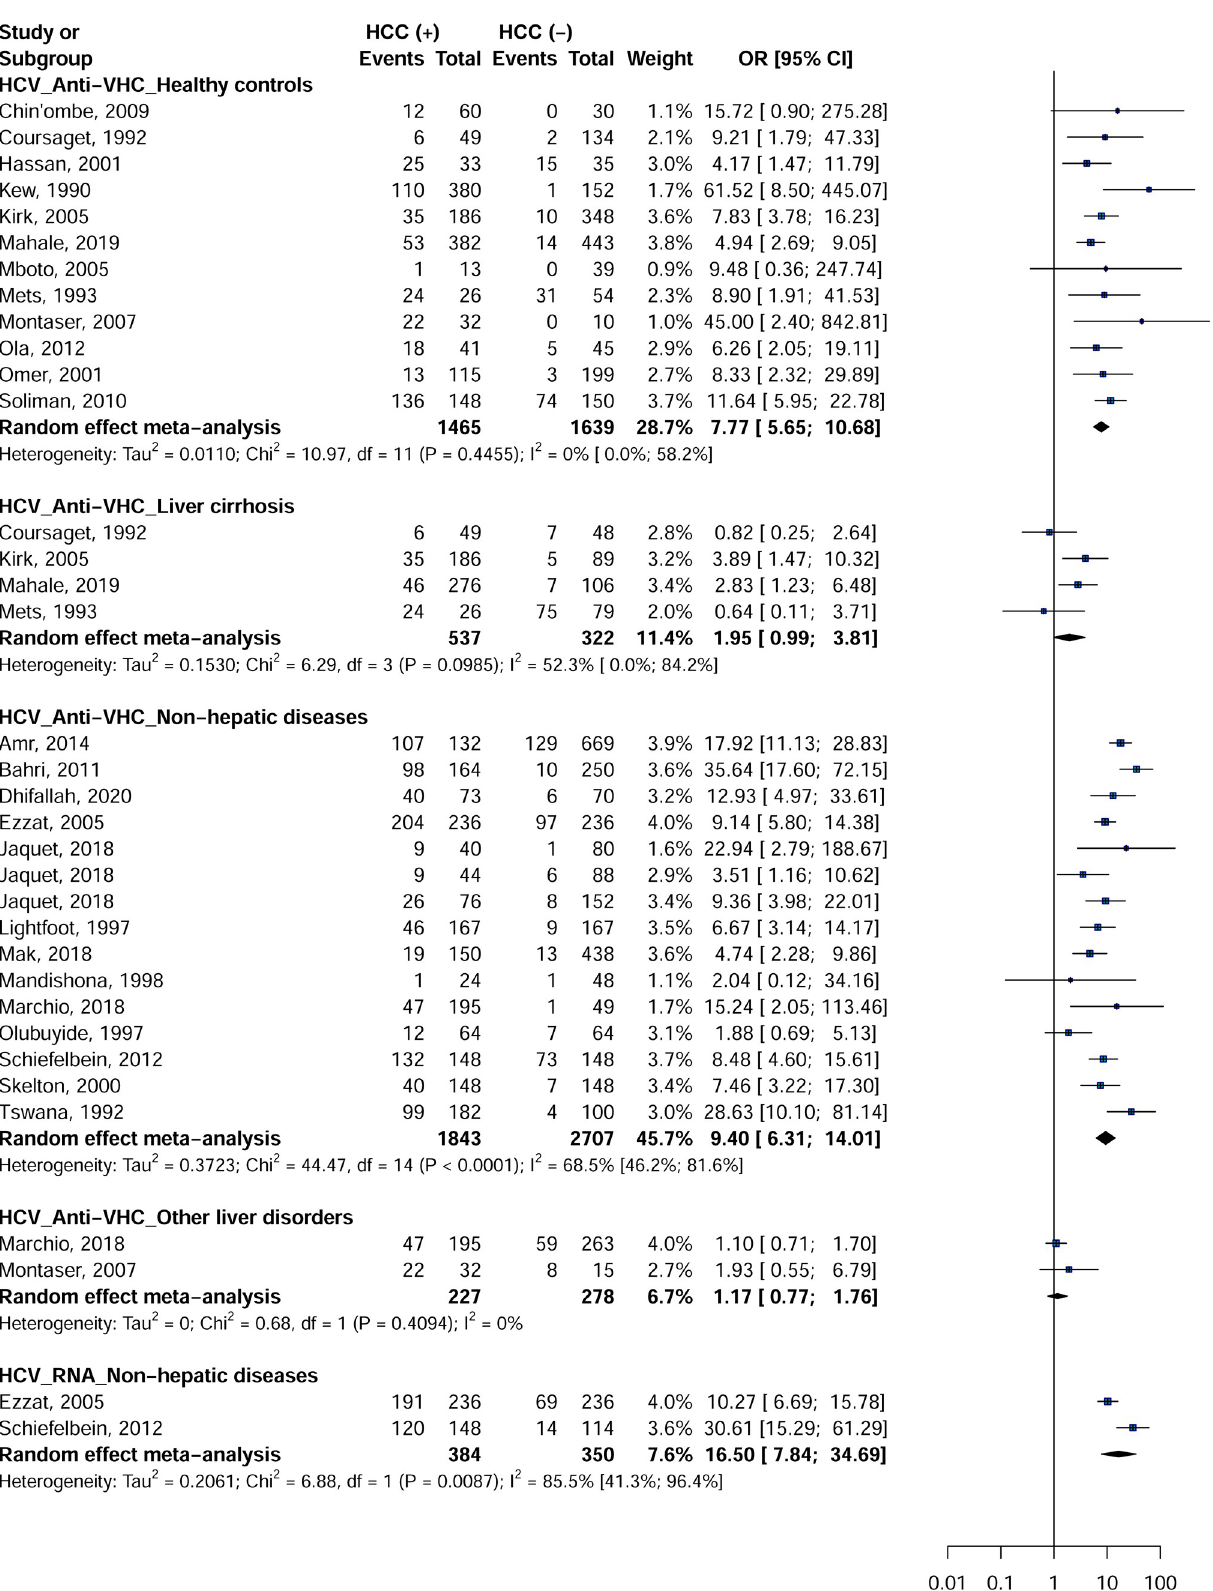
Fig 3. Association between Hepatitis C Virus infection and risk of hepatocellular carcinoma in Africa.